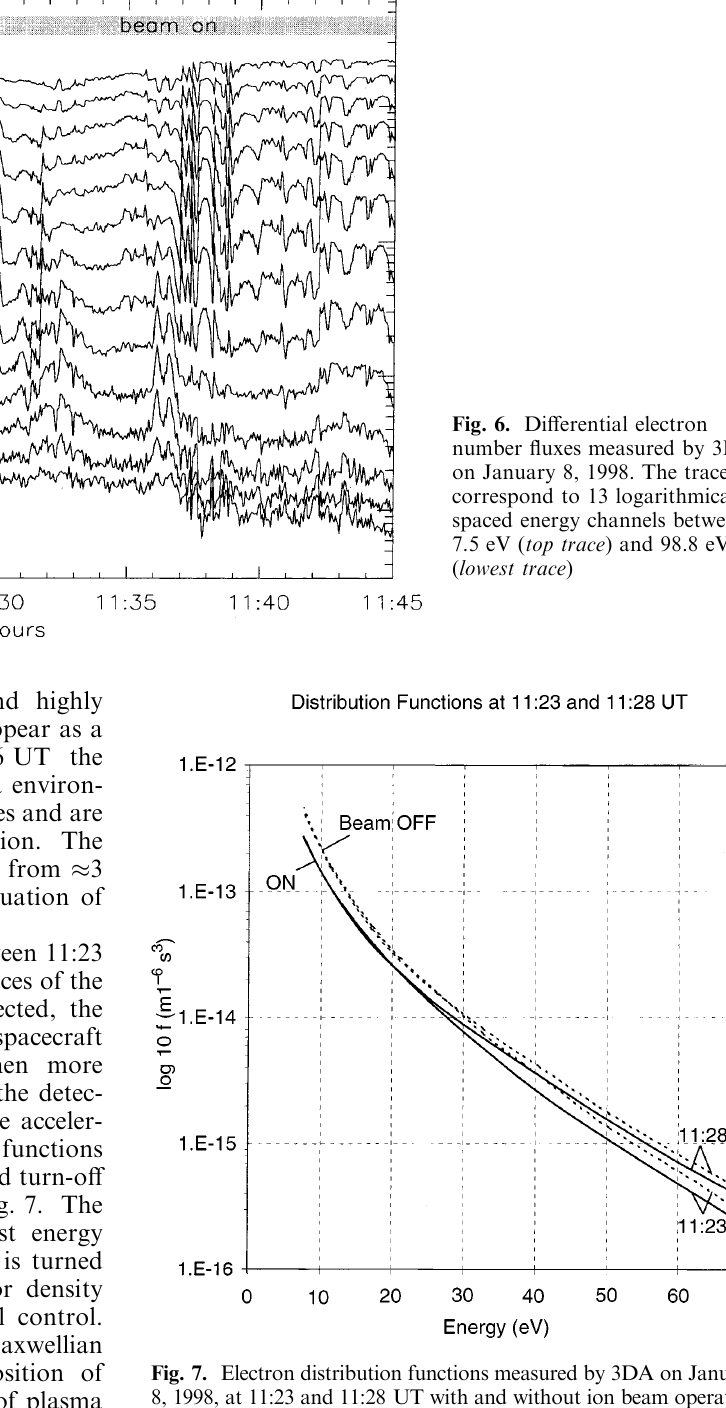
Fig. 7. Electron distribution functions measured by 3DA on January 8, 1998, at 11:23 and 11:28 UT with and without ion beam